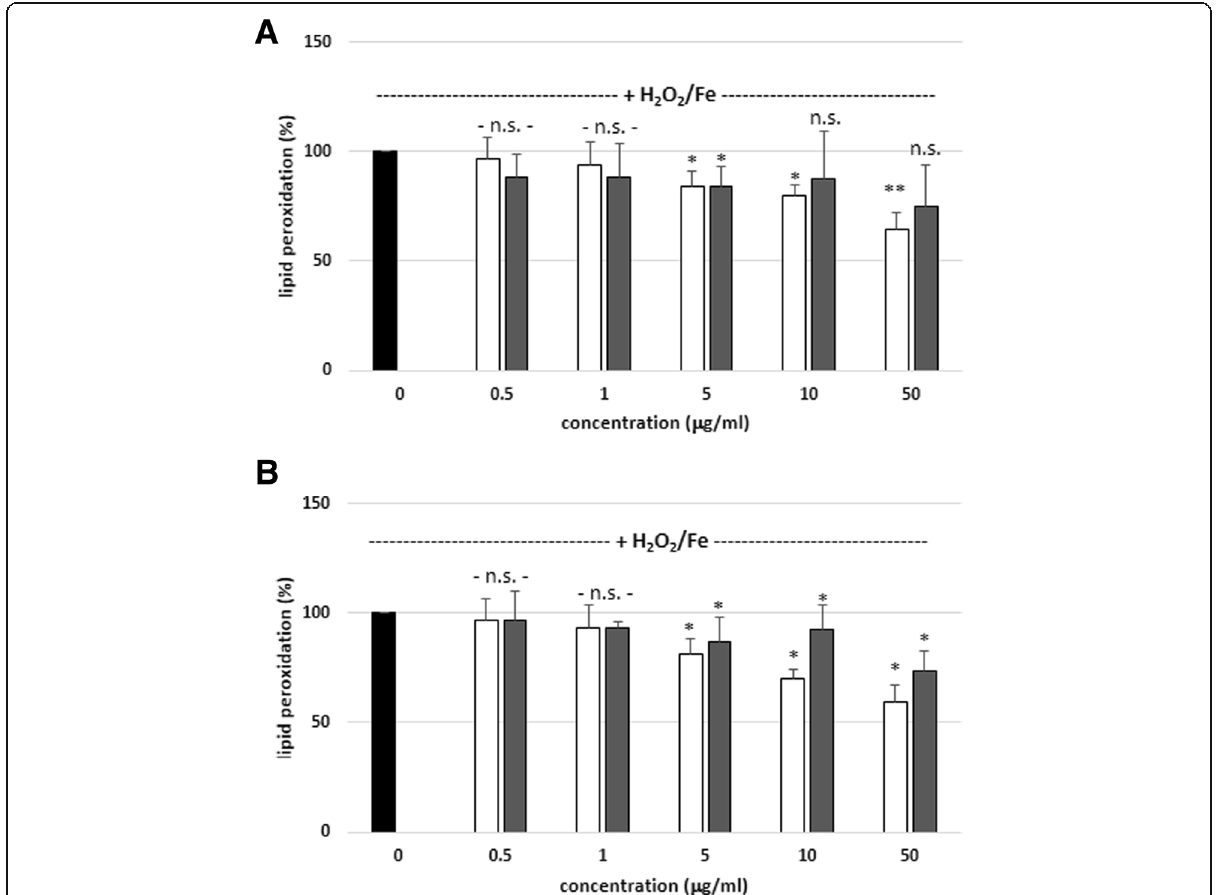
Fig. 2 Effects of SBT twig and leaf extracts (0.5 – 50 μ g/mL; 15 min ( a ) and 60 min ( b )) on plasma lipid peroxidation induced by H 2 O 2 /Fe. In these experiments, the TBARS level (marker of lipid peroxidation) in control samples (plasma treated with only H 2 O 2 /Fe) was 0.341 ± 0.078 nmol/mL of plasma. Data represent means ± SD of 5 – 10. The effect of two different concentrations of two tested extracts (0.5 and 1 μ g/mL; for 15 and 60 min) was not statistically significant ( p > 0.05 (n.s.)) in comparison to control. The effect of two different concentrations of SBT leaf extract (10 and 50 μ g/mL; for 15 min) was not statistically significant ( p > 0.05 (n.s.)) in comparison to control. The effect of three different concentrations of SBT twig extract (5, 10 and 50 μ g/mL; for 15 min) was statistically significant (* p < 0.05, ** p < 0.005) in comparison to control. The effect of one concentration of SBT leaf extract (5 μ g/mL; for 15 min) was statistically significant (* p < 0.05) in comparison to control. The effect of three different concentrations of two tested extracts (5, 10 and 50 μ g/mL; for 60 min) was statistically significant (* p < 0.05) in comparison to control. The effects were not statistically significant: SBT twig extract-treated plasma vs. SBT leaf extract-treated plasma (for 15 min: p > 0.05 (n.s.), for all tested concentrations- 0.5 - 50 μ g/mL); for 60 min ( p > 0.05 (n.s.), for tested concentrations: 0.5, 1 and 10 μ g/mL). The effects were statistically significant: SBT twig extract-treated plasma vs. SBT leaf extract-treated plasma, (for 60 min, p < 0.05 for tested concentrations: 10 and 50 μ g/mL). black diagram – control, white diagram – twig, grey diagram -